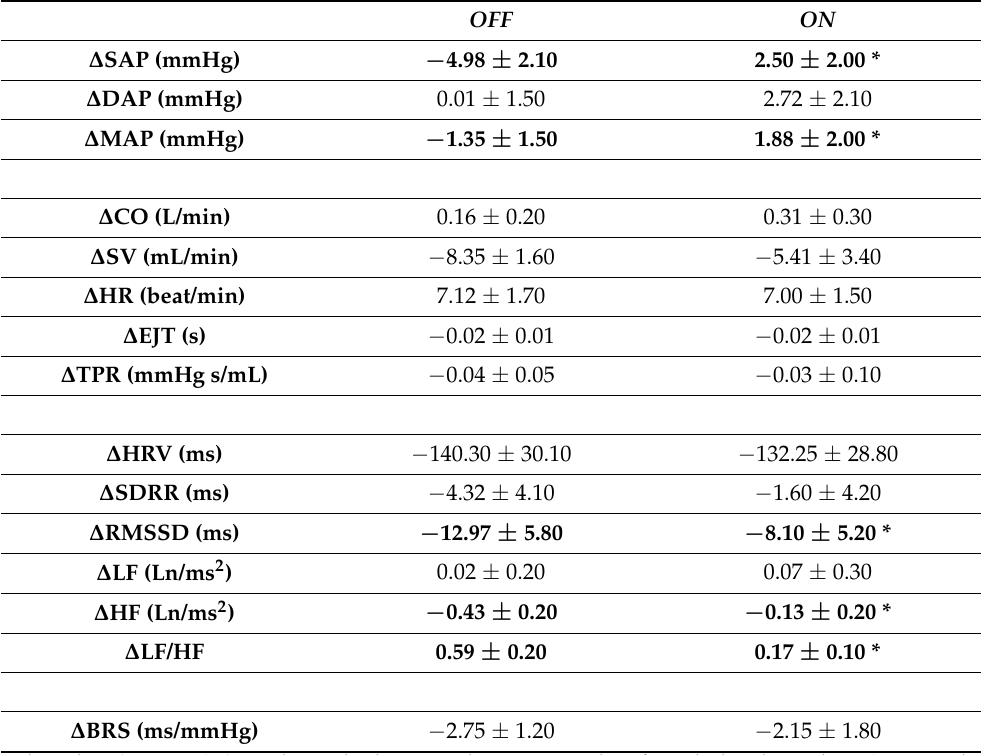
Table 4. Hemodynamic and autonomic variables.